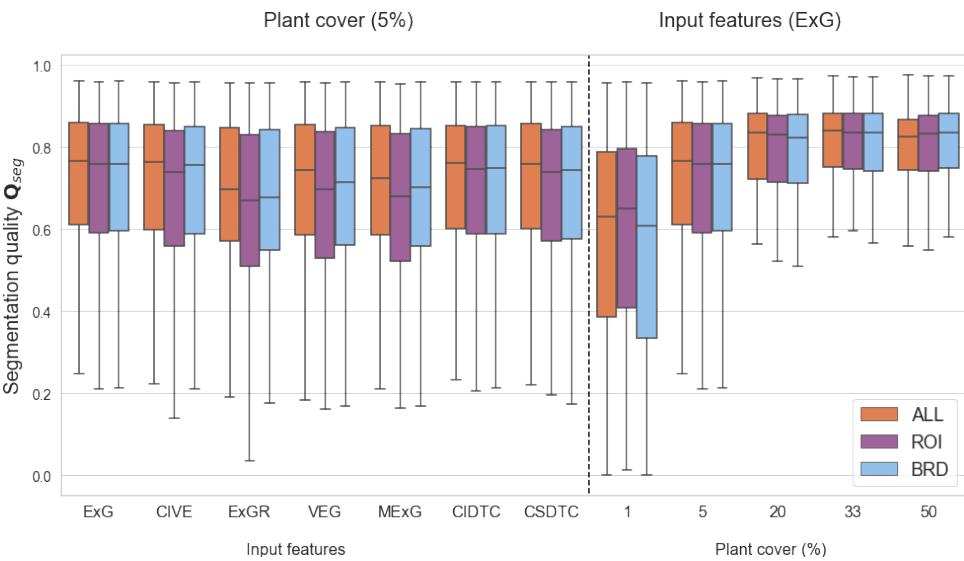
Figure 3. Influence of pixel selection criteria on segmentation quality fixing plant cover at 5% ( left ) and input feature at ExG ( right ). Box plots show the range of segmentation quality Q seg of the 100 evaluation images omitting outliers. Pixel selection has the values ALL (uses the full hand- annotated segmentation mask), BRD (removes pixels from the annotation mask border) and ROI (uses the pixels within the region of interest). Tested models are single-feature input DTC based on Excess Green (ExG), Color Index of Vegetation Extraction (CIVE), Excess Green minus Excess Red (ExGR), Vegetative Index (VEG) and Modified Excess Green (MExG), furthermore the multi-feature input decision tree classifiers based on 7 color indices (CIDTC) and 18 color channels